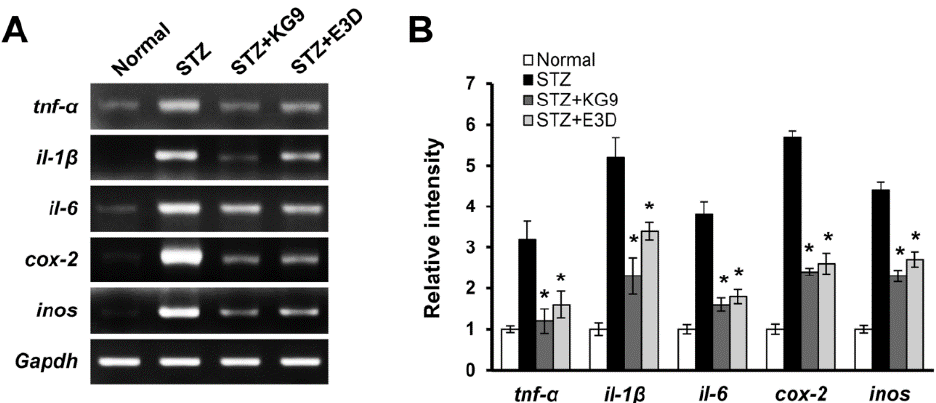
Figure 8. GS-KG9 and GS-E3D inhibit the expression of proinflammatory cytokines and mediators in the hippocampus of STZ-induced diabetic rats. Total RNA from saline, GS-KG9, and GS-E3D (300 mg/kg)-treated hippocampal tissue at 28 d after drug treatment was prepared as described in the Materials and Methods section. ( A ) RT-PCR of tnf- α , il- 1β , il-6 , cox-2 , and inos. ( B ) Quantitative analysis of RT-PCR. Data are presented as the mean ± SD. * p < 0.05 vs. STZ control ( n = 3 rats/group).